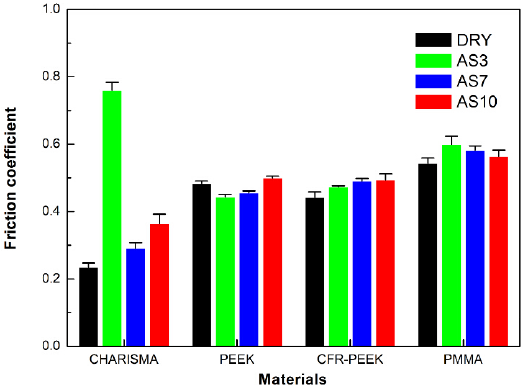
Figure 6. Friction coefficient, means of 30 nanoscratch (3 indentations each sample) of CHARISMA, PMMA, PEEK, and CFR-PEEK before and after treatment. The bars represent standard